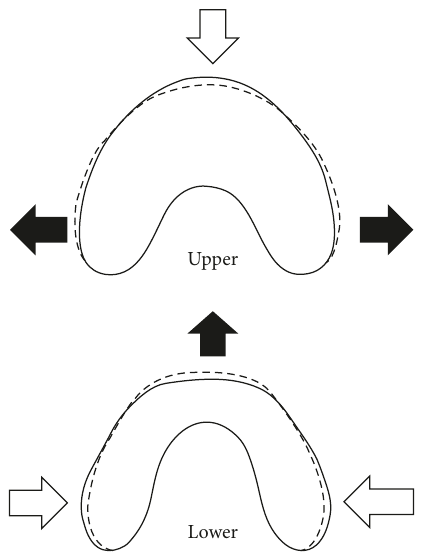
Figure 4: Illustration of the force direction on the OAs. Black arrow, outside direction; white arrow, inside